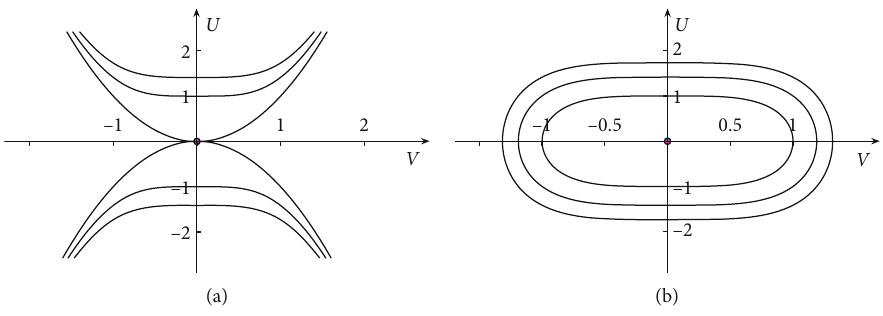
= 1 and (b) a = − 1 . 4 4